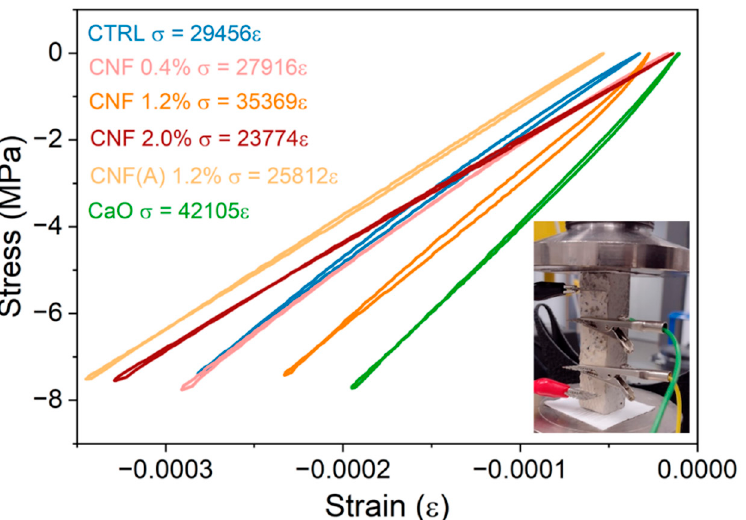
Figure 8. Stress–strain relationship of mortar specimen under compressive loading. Inside detail: experimental setup for the piezoresistivity testing.